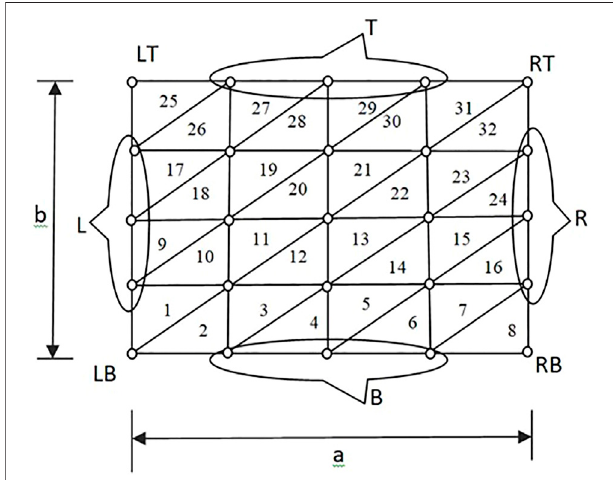
FIGURE 5 | FE model (triangular mesh (4 × 4)) for one periodic unit showing nodes corresponding to left(L), left bottom (LB), bottom (B), right bottom (RB), right(R), right top (RT), top(T), and left top